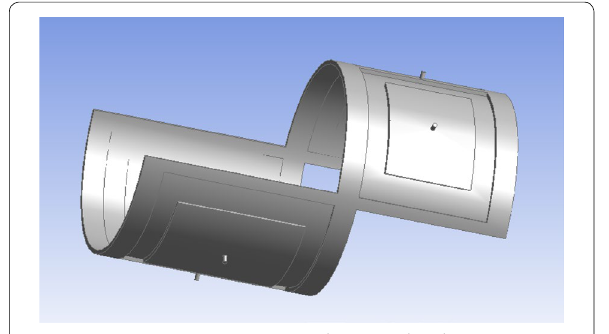
Figure 3 Asymmetric static-pressure bearing oil pads